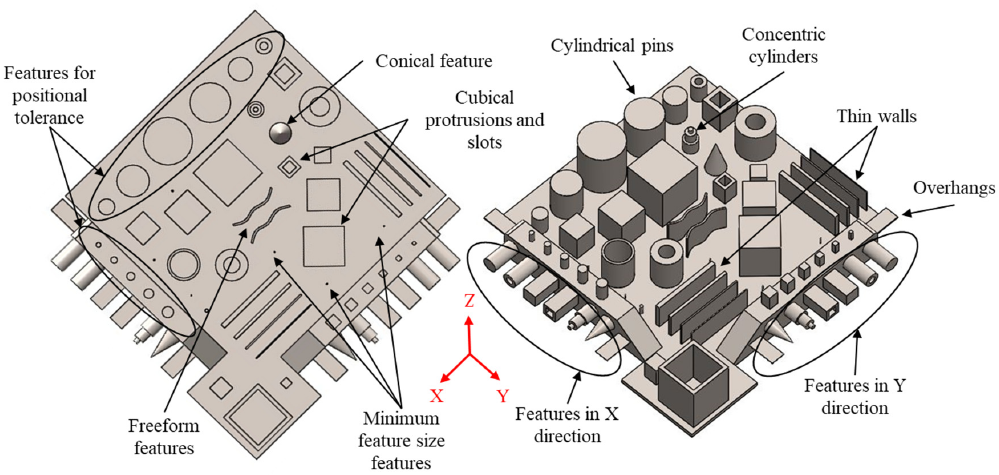
Figure 1. Nominal GBTA design and corresponding features. ( Left ) Top view and ( Right ) isometric view.